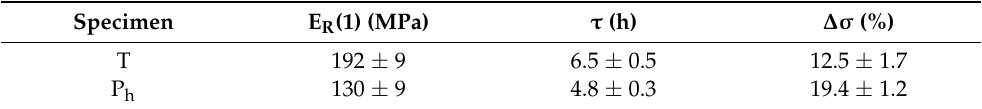
Figure 7. Evaluation of stress relaxation behavior, over time, of the printed specimens after in vitro aging: ( a ) T and ( b ) P h . Table 6. Mean and standard deviation values of the mechanical properties calculated from the stress relaxation tests of the printed specimens after in vitro aging.